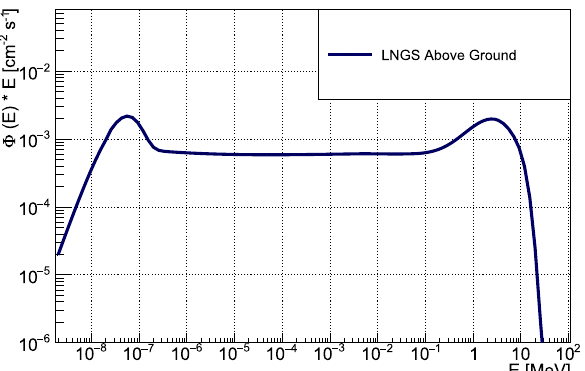
Fig. 4 Spectrum of neutrons measured above-ground at the INFN- LNGS. The total flux is 0.018n/cm 2 /s, with an average experimental data uncertainty of 7%